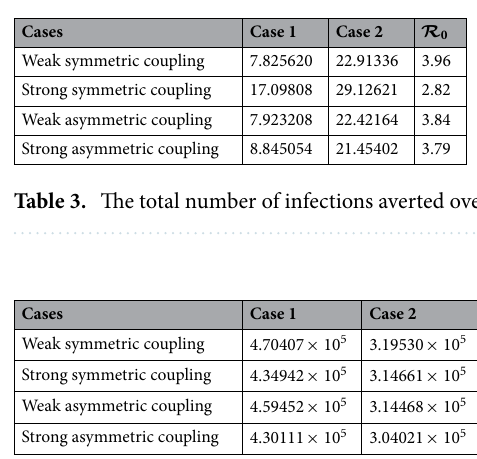
Table 4. The total cost with respect to the control policy, over a 100 day